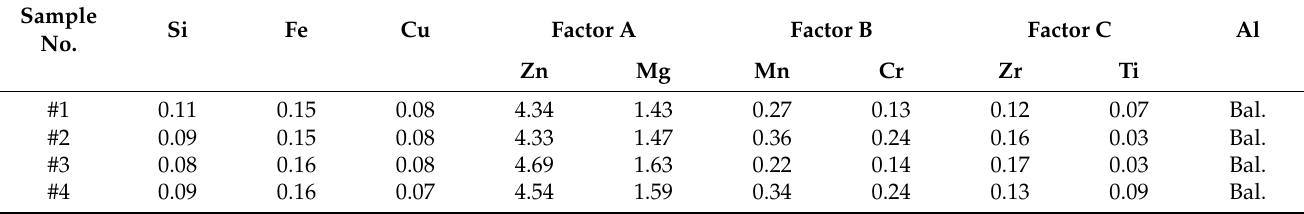
Table 2. Elemental composition of tested A7N01S-T5 alloys (wt.%)